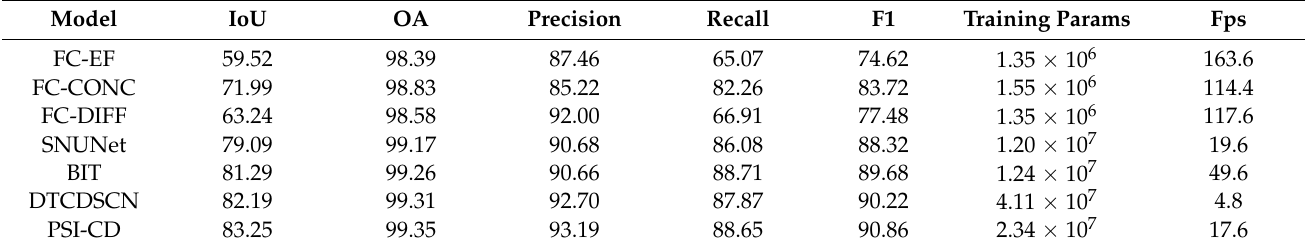
Table 1. Comparison of change detection results on WHU dataset (unit: